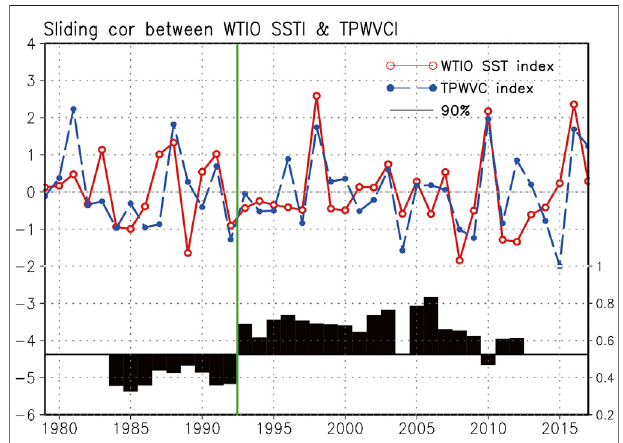
FIGURE 3 | Time series of WTIO SSTI (red line, left coordinate), TPWVCI (blue line, left coordinate) and 11-year sliding correlation coef fi cients between WTIO SSTI and TPWVCI (black bar, right coordinate). The solid black line indicates the threshold of 90% con fi dence level. Green vertical line indicates the decadal change point at 1992/1993.